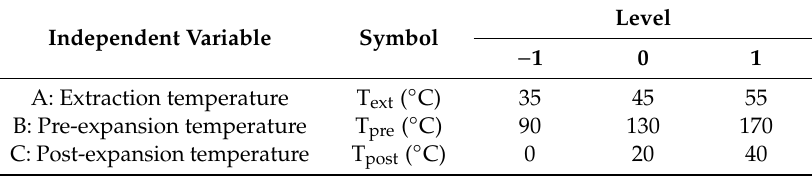
Table 1. Factor levels of RESS Box–Behnken design. Independent